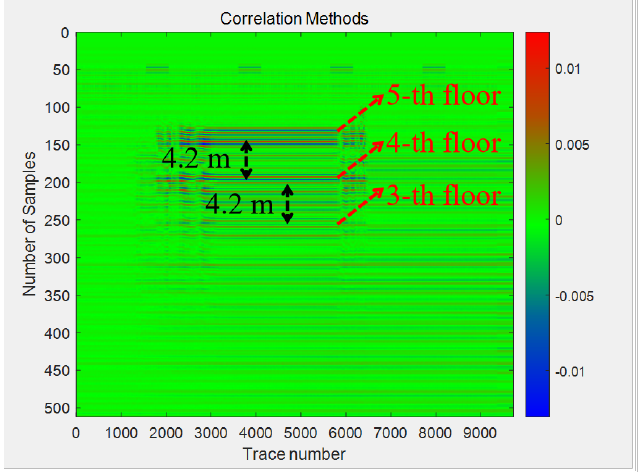
Figure 14. The measurement results of static